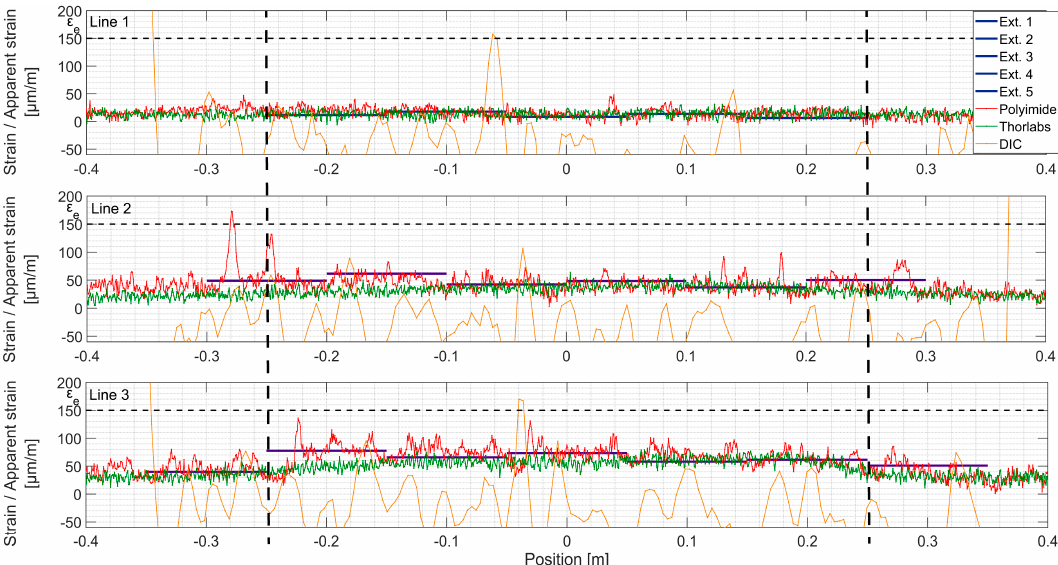
Figure 10. Strains measured with di ff erent techniques, load step 1, F = 20 kN; the constant bending moment zone is marked with dashed lines.